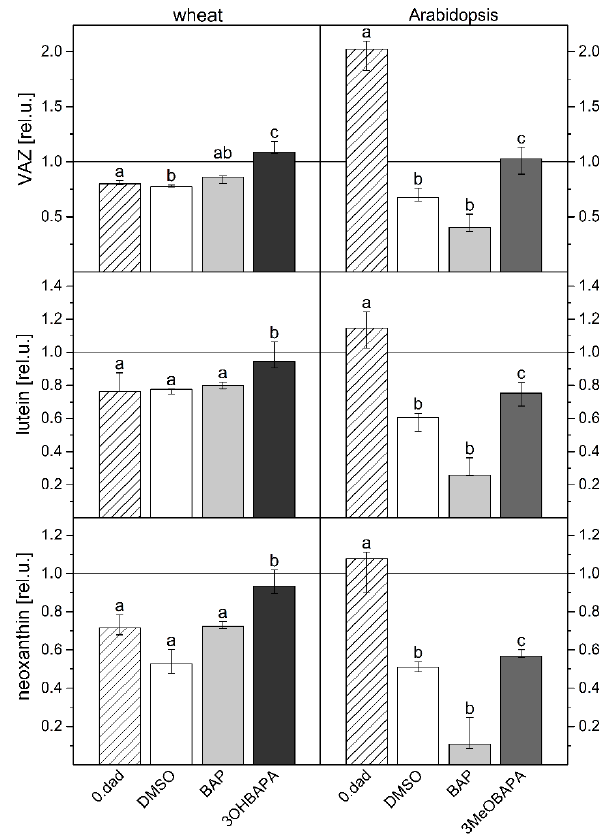
Figure 10. Violaxanthin, antheraxanthin, zeaxanthin (VAZ), lutein, and neoxanthin content (relatived to the value before high-light treatment) in control (0. dad) and detached leaves of wheat and Arabidopsis incubated in 0.1% DMSO or 10- µ mol · L − 1 solutions of BAP, 3OHBAPA or 3MeOBAPA. Leaves were kept in the dark for 6 days and subsequently exposed to high light (500 µ mol photons · m − 2 · s − 1 for 4 h). Medians and quartiles are presented ( n = 4–5). Di ff erent letters indicate a statistically significant di ff erence between treatments within a plant species ( p < 0.05; Student’s unpaired t